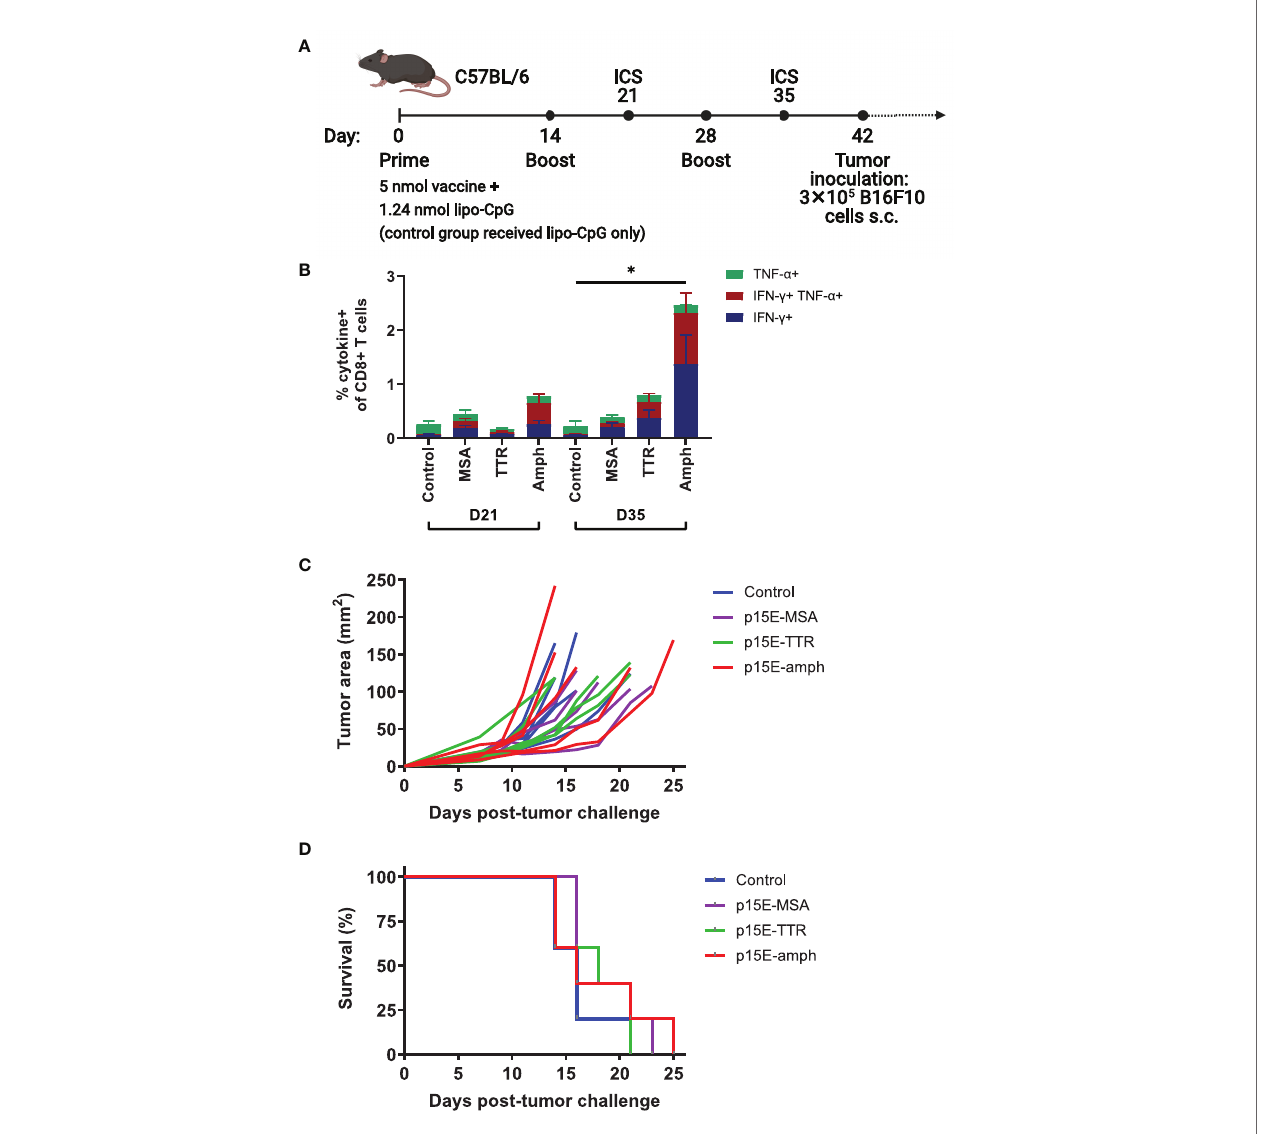
FIGURE 4 | Vaccination against p15E induces minimal expansion of p15E-reactive T cells and does not result in tumor protection. (A) Timeline of vaccination and tumor inoculation with B16F10 cells (ICS = intracellular cytokine staining, s.c. = subcutaneous). (B) On days 21 and 35, peripheral blood samples from each mouse were stimulated with p15E peptide in the presence of brefeldin A for 4 hours. Intracellular cytokine staining was performed to assess CD8 + T cell reactivity to p15E peptide. *P < 0.05 by one-way ANOVA with Tukey ’ s multiple comparisons test. Data shown is mean+s.e.m. (C, D) Tumor areas were measured every other day beginning 3 days post-inoculation. Mice were euthanized when tumor area exceeded 100 mm 2 . Shown are tumor areas for individual mice (C) and survival (D) . N=5